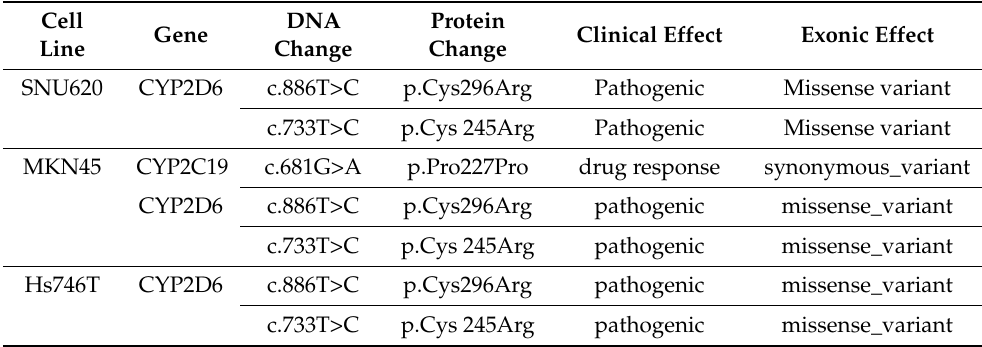
Table 1. Summary of pathogenic variants of individual